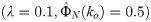
Forecasting results.a) Plot of N-step force forecasts with CFDL-MFP (magenta), auto-ARIMA (dark orange), and manual ARIMA (dotted cyan) for force data sampled at 5ms. The CFDL-MFP parameters are initialized with (λ=0.1,Φ^N(ko)=0.5). b) Plot of RMSE showing spikes at rapidly changing force profiles. CFDL-MFP forecasts were most accurate for profiles (A,C,D).